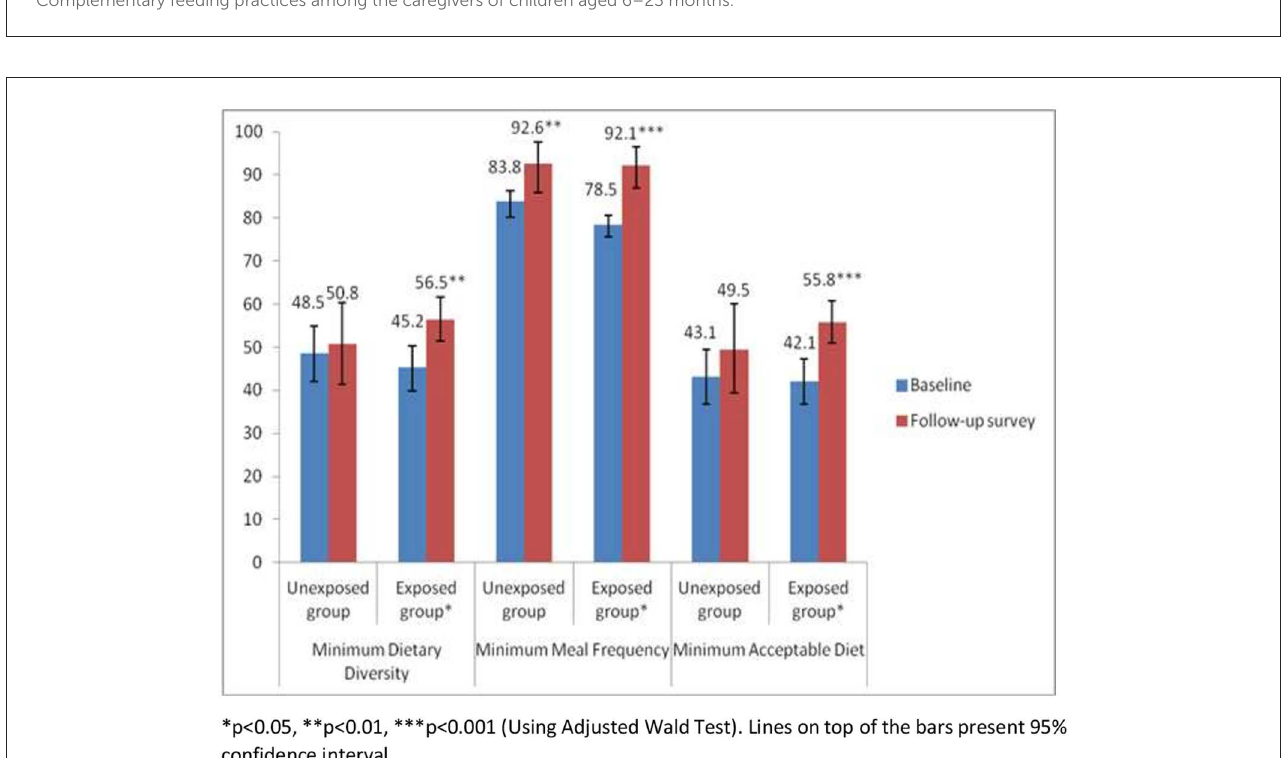
FIGURE3 Complementary feeding practices among the caregivers of children by exposed and unexposed groups.